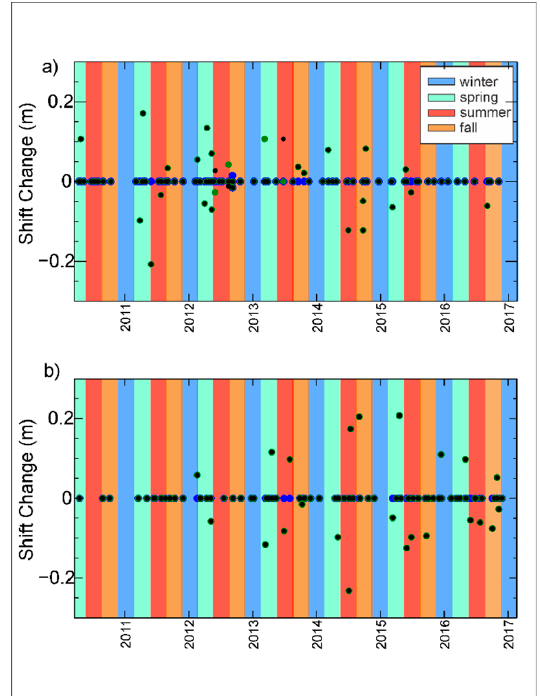
Figure 14. Shift variation value as function of the season. Black, green and blue dots represent the shift values applied to the section, channel, and overbank control areas, respectively. ( a ) Wapsipinicon River near Oxford Mills; ( b ) Skunk River at Merrimac.